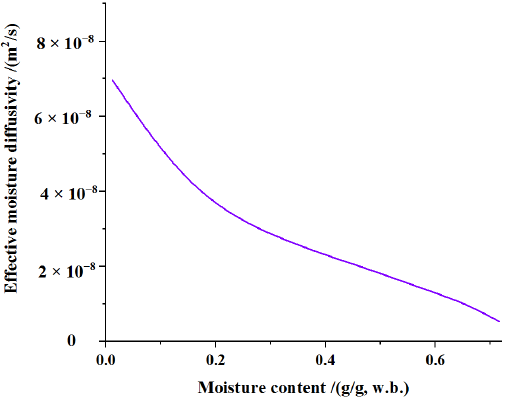
Figure 4. Dependence of effective moisture diffusivity on moisture